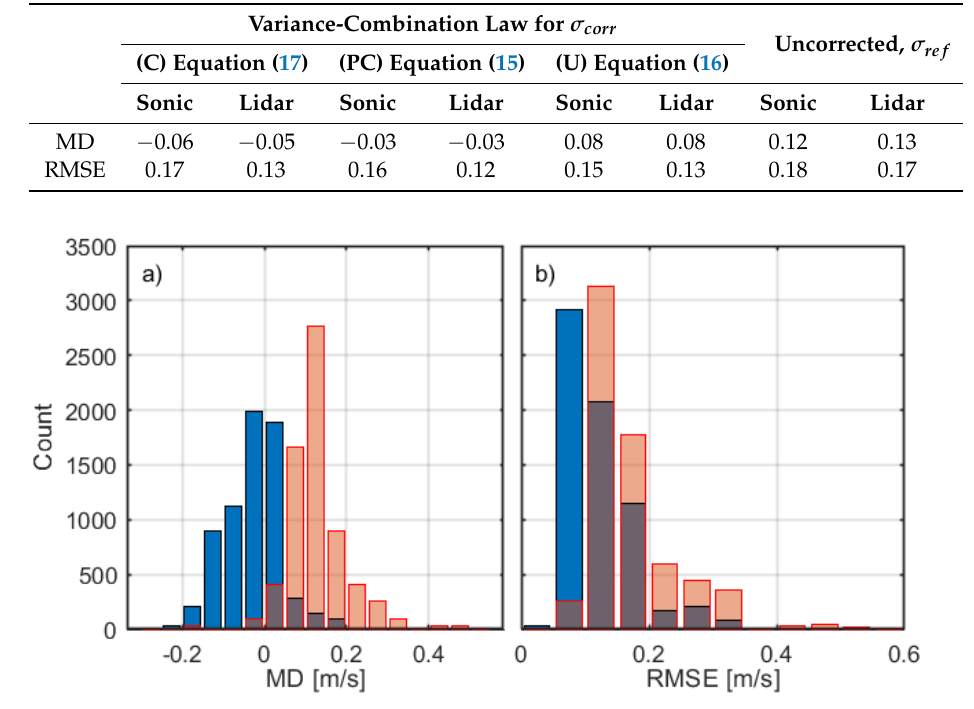
Table 3. Performance of the variance-combination laws of Section 3.2. (C) stands for linearly correlated variables, (PC) for partially correlated, and (U) for uncorrelated.